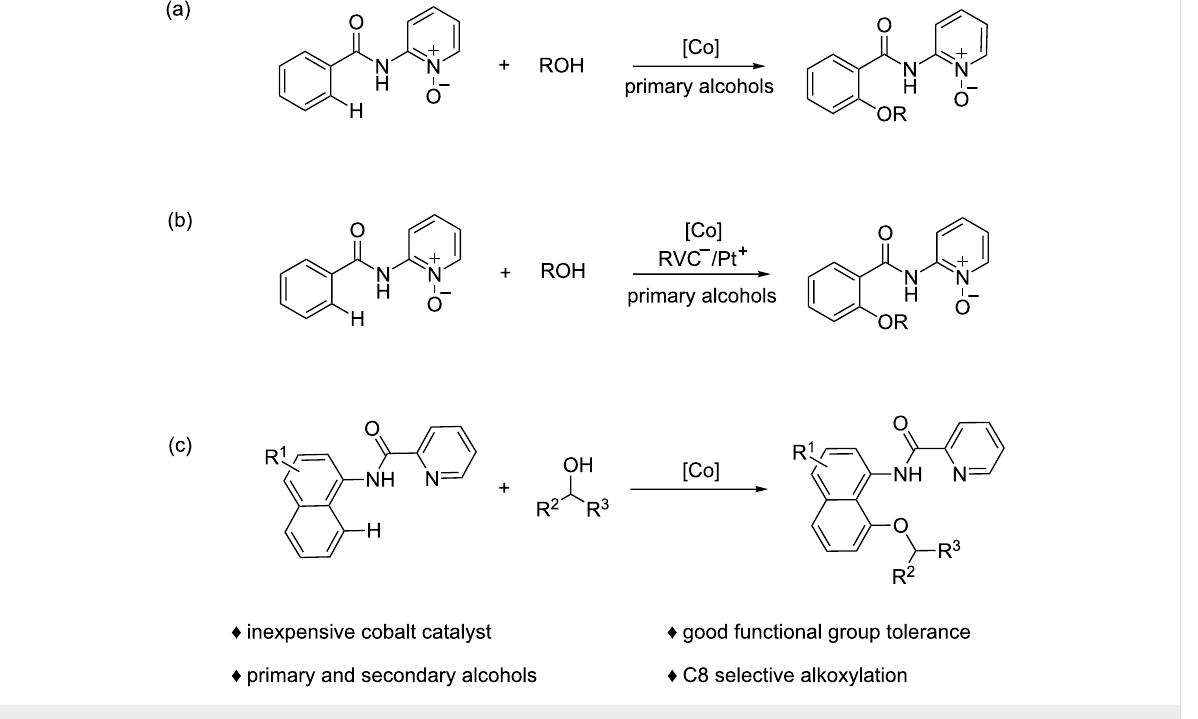
Figure 1: Strategies for cobalt-catalyzed